Question: Which visualization type does this figure use?
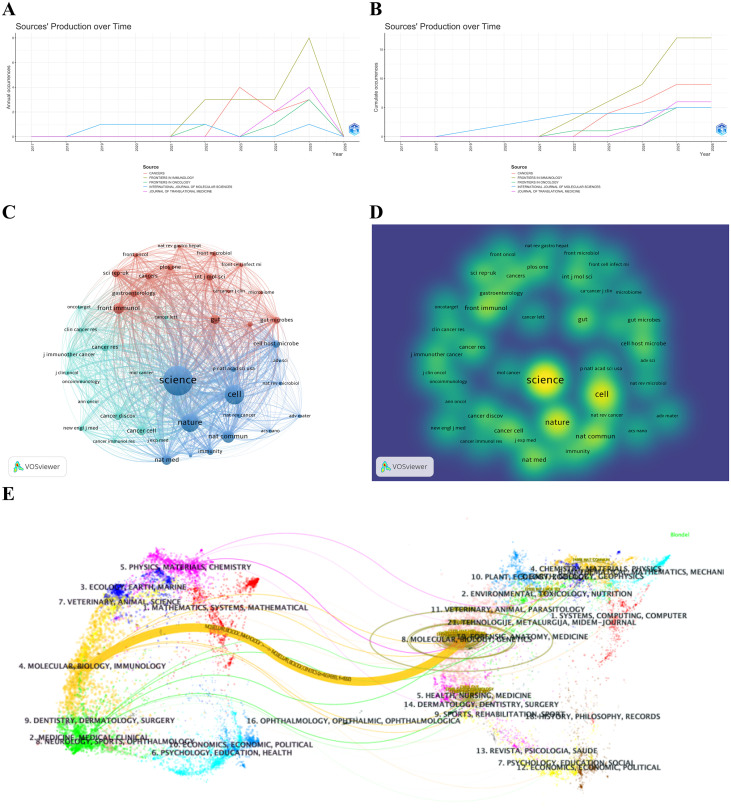
Answer: line